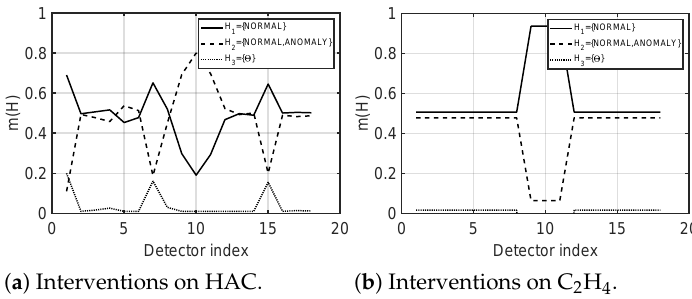
Figure 13. Mass function assignment in two intervention scenarios.